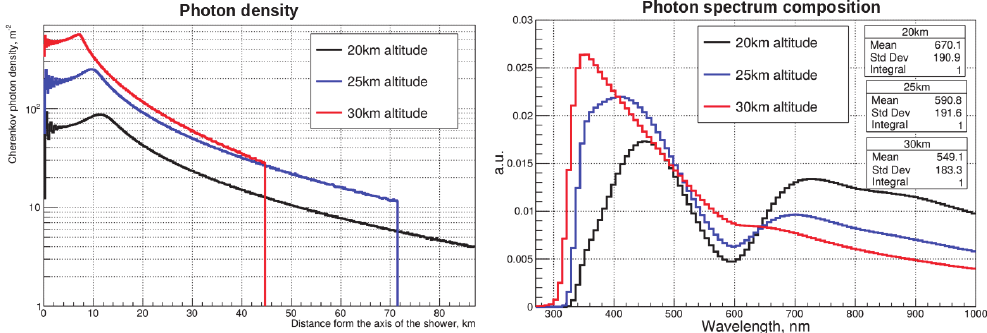
Figure 11: Left : Photon density of the Cherenkov ring as seen from the telescope produced by 100 PeV protons for di ff erent heights as a function of distance from the shower axis. Right: Photon spectral composition for showers produced at di ff erent altitudes in the atmosphere. The deeper the shower the more the photons will be scattered in the atmosphere and spectral emission moves toward the red band.